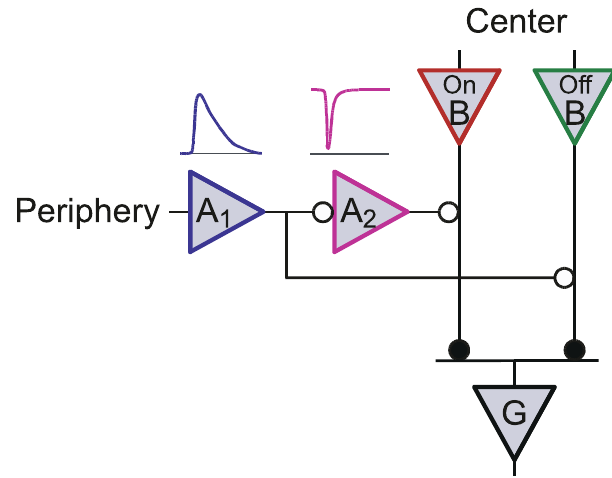
Figure 7. An Amacrine Cell Circuit to Explain Polarity Reversal An On-Off ganglion cell (G) receives excitatory input (closed circles) from On and Off bipolars (B) in the receptive field center, whose gain is modulated by presynaptic inhibition from amacrine cells (open circles). The peripheral shift depolarizes (see time course above A 1 ) an amacrine cell (A 1 ), which in turn suppresses transmission from the Off bipolar channel. Amacrine A 1 also inhibits a second amacrine (A 2 ), which leads to transient disinhibition (see time course above A 2 ) of the On bipolar pathway. See text for details.